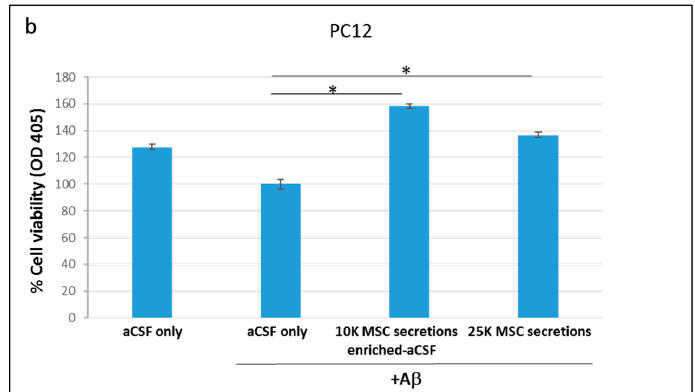
Figure 2. Enriched-aCSF increases cell viability of neuronal cell lines exposed to A β neurotoxin. ( a ) While SH-SY5Y cell viability was reduced under A β , a significant increase in cell viability was noticed in the enriched-aCSF ( t -test, p = 0.0002, p = 0.00003, in 10 and 25 K/mL, respectively) with a comparable effect of the secretions of both MSCs concentrations; ( b ) Similarly, while PC12 cell viability was reduced under A β , a significant increase in cell viability was noted in the enriched-aCSF treated cells (10 K: increase of 58.1% (Mann Whitney U, p = 0.02), 25 K: increase of 36.5% ( t -test, p = 0.00004) with a comparable effect of the secretions of both MSCs concentrations. OD 405 = optical density at 405 nm.